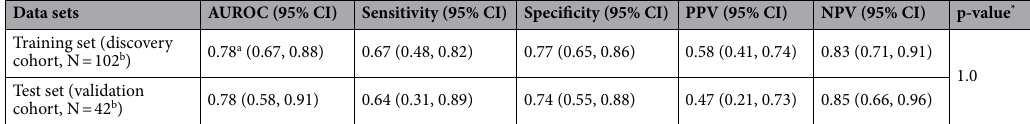
Table 2. The perfromance of the integrated radiomic-clinical classification model to differentiate MMR-D from CN-low-like and CN-high-like ECs. EC endometrial cancer, AUROC area under the receiver operating curve, CI confidence interval, PPV positive predictive value, NPV negative predictive value, MMR-D DNA mismatch repair-deficient, CN copy number. * deLong test. a Cross-validated AUROC. b Patients with polymerase epsilon (POLE) subtypes of EC were excluded from this